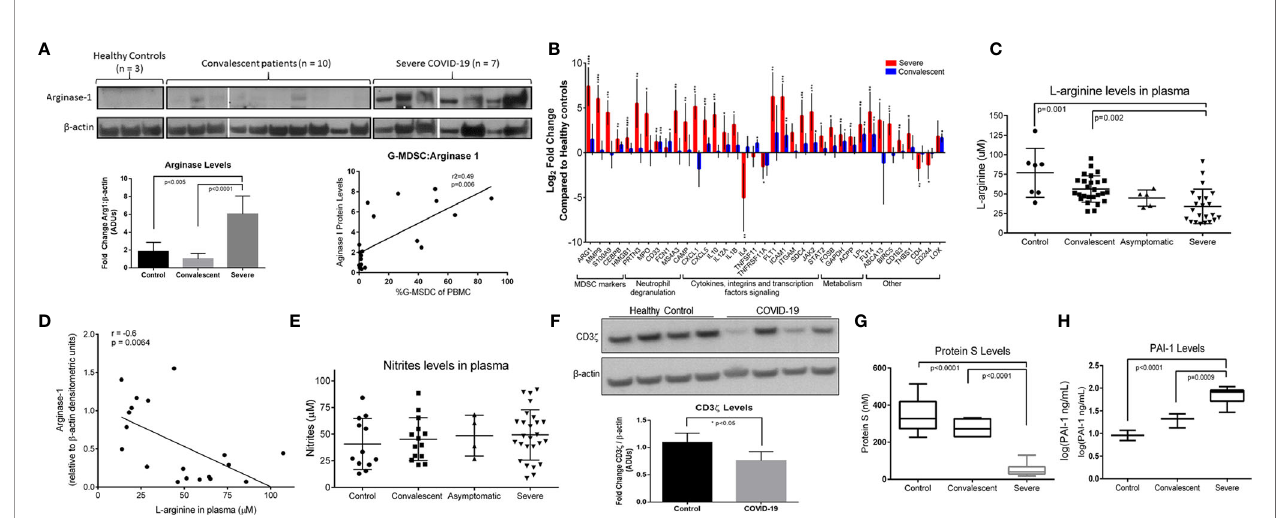
FIGURE 3 | Effects of Increased Arg + G-MDSC. (A) Arginase-1 protein expression in PBMC from severe, convalescent COVID-19 patients and healthy controls with associated quanti fi cation of fold-changes. (B) Gene expression comparison by SYBR green qRT-PCR of PBMC from severe (red bars) and convalescent (blue bars) and healthy controls (baseline). X axis shows Log2 fold change in gene expression. Asterisks denote *p ≤ 0.05, **p ≤ 0.01, ***p ≤ 0.001, and ****p ≤ 0.0001, using Student ’ s t-test from the average D Ct values. (C) L-arginine concentration in plasma of patients and healthy controls (D) Correlation of Arg-1 protein expression in PBMC and plasma arginine. (E) Plasma nitrate levels in plasma. (F) CD3 z chain expression in puri fi ed T cells from 4 representative healthy controls and 4 COVID-19 patients with average densitometry shown below with a student ’ s t-test with Welch ’ s correction. (G) Plasma protein S and (H) plasminogen activator inhibitor-1 (PAI-1) in